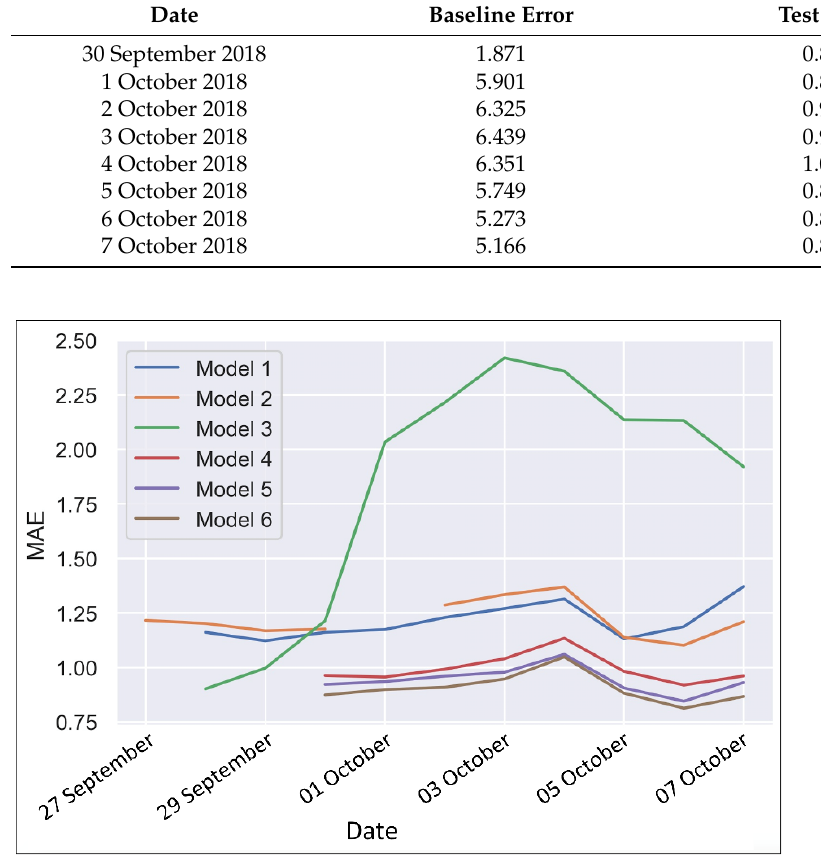
Figure 10. The plot of daily test errors of model-1, 2, 3, 4, 5, 6.